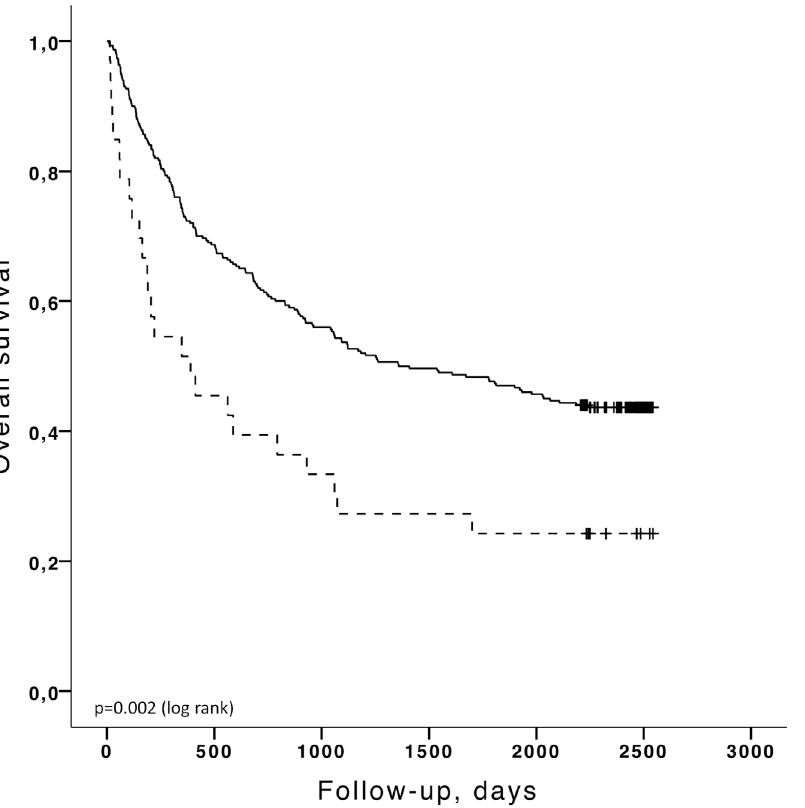
Figure 5. Kaplan-Meier analysis for the probability of over-all survival according to BNP levels below (black, solid) or above the cut- off level of 100 pg/ml (black, dashed).